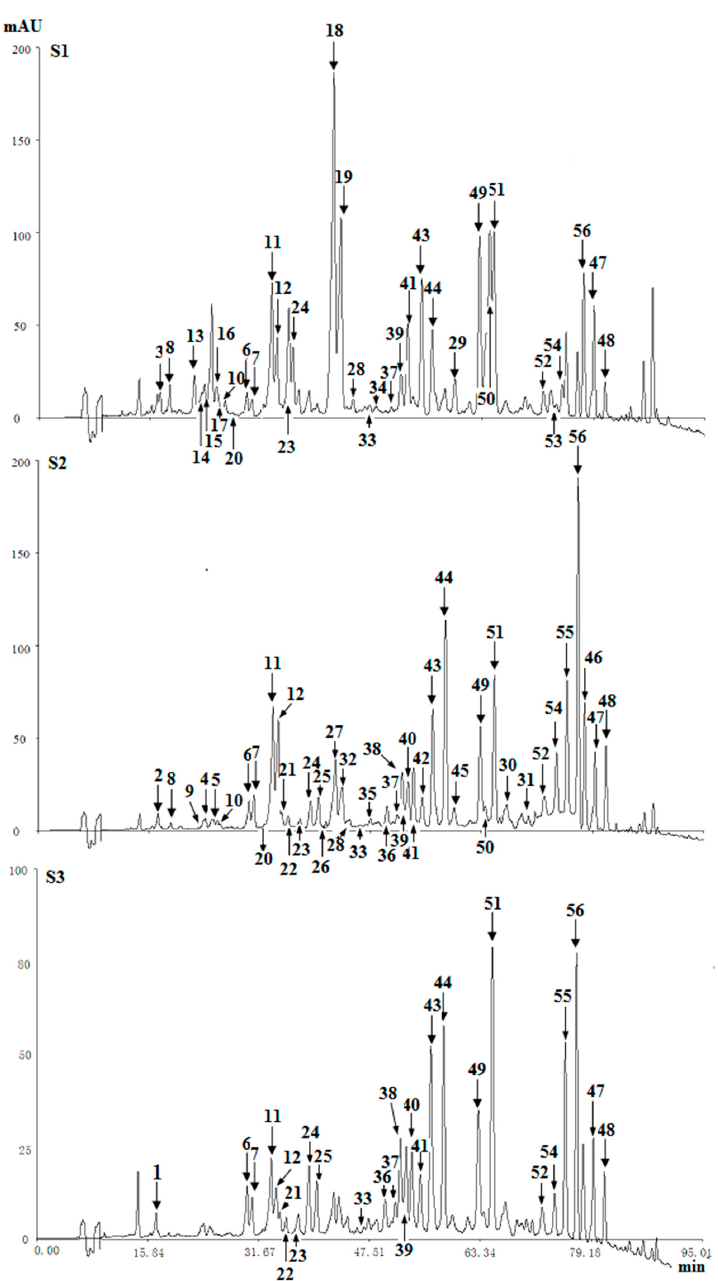
Figure 3. Chromatograms of three agarwood samples (S1, S2, S3) at 254 nm.